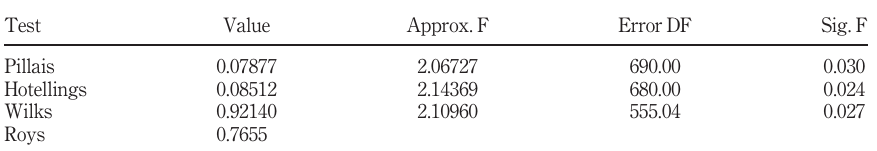
Table VIII. Multivariate test